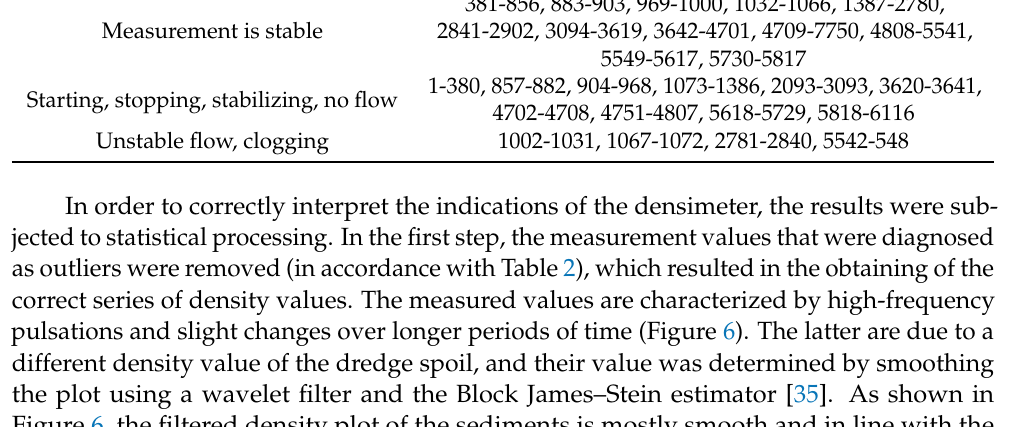
Table 2. Results of the analysis of the unstable operation of the densimeter.